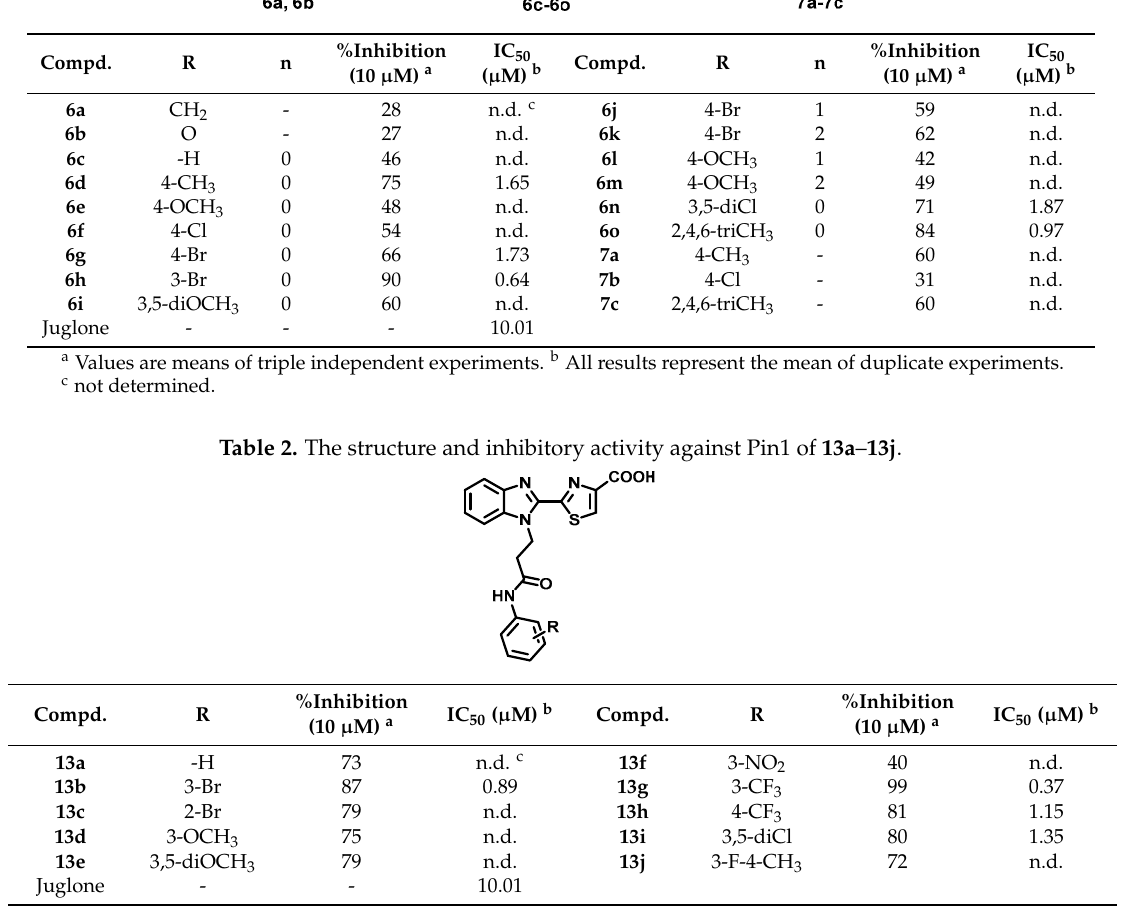
a Values are means of triple independent experiments. b All results represent the mean of duplicate experiments. c not